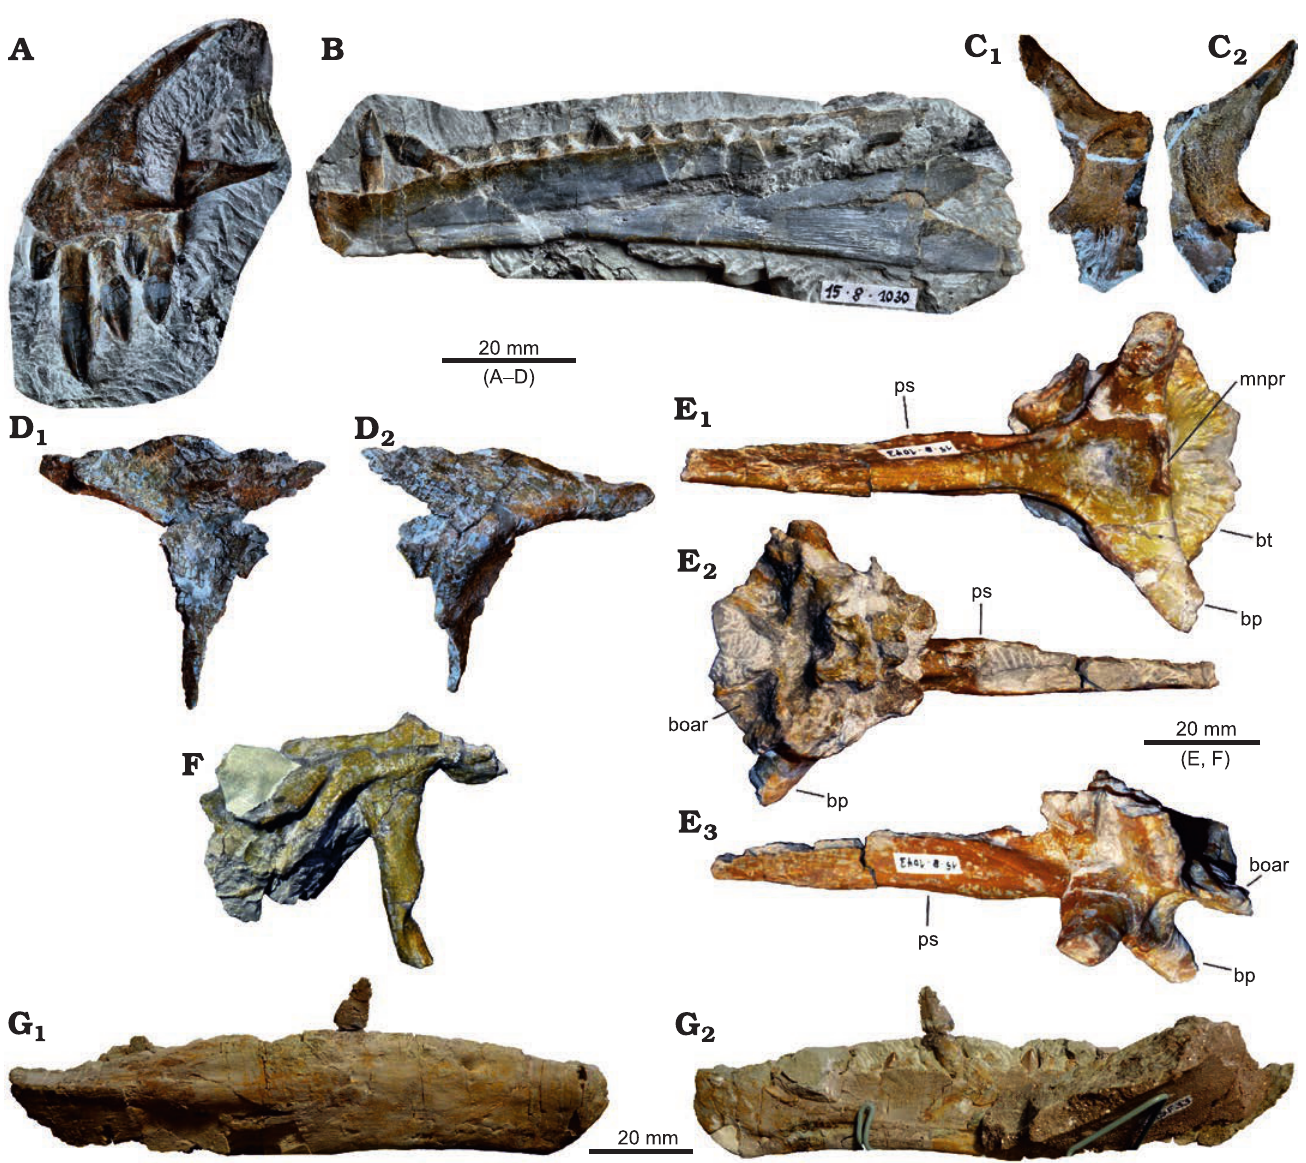
Fig. 9. Plateosaurus trossingensis material from the Triassic of Frick, Switzerland. A – D . Disarticulated skull of the early-stage juvenile (MSF 15.8B). A . MSF 15.8.935, premaxilla in medial view. B . MSF 15.8.1030, dentary in medial view. C . MSF 15.8.2029, left parietal in ventral (C 1 ) and dorsal (C 2 ) views. D . Left prefrontal (MSF 15.8.2028), in medial (D 1 ) and lateral (D 2 ) views. E , F . Isolated skull fragments pertaining to different individuals. E . Basisphenoid and parasphenoid (MSF 15.8.1043), in ventral (E 1 ), dorsal (E 2 ), and posterolateral (E 3 ) views (photographs by Ursina Bachmann). F .